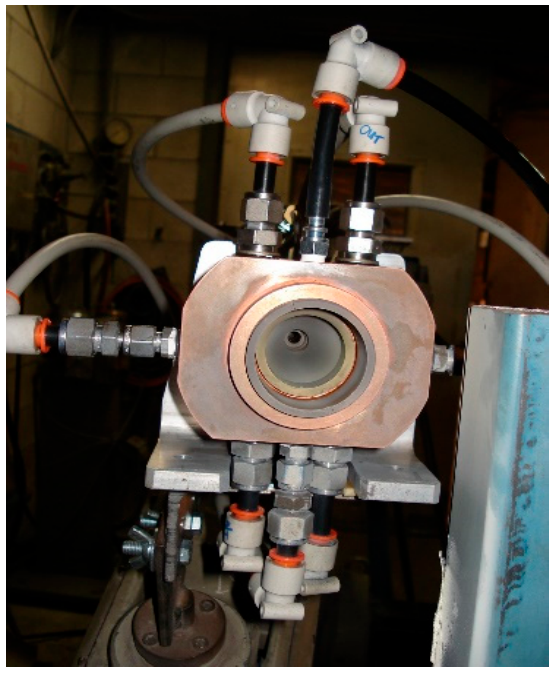
Figure 1. The shroud attachment for plasma-sprayed titanium coatings. Table 2. The plasma-spraying parameters for the titanium coatings with the shroud. Spray Parameter